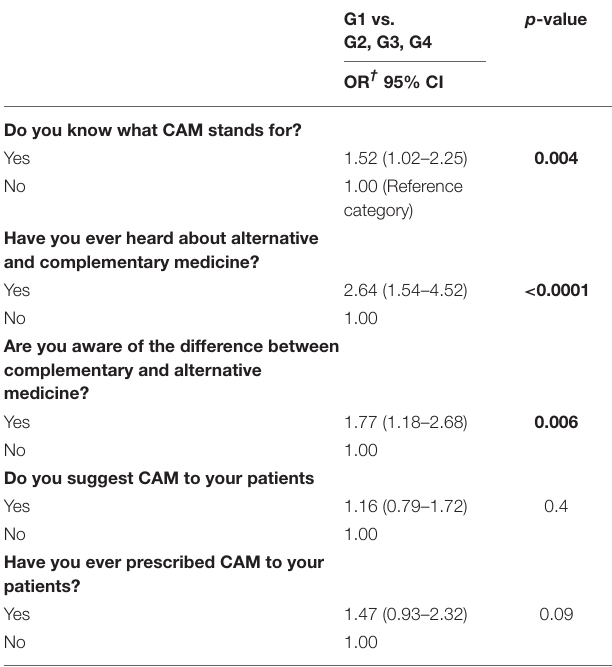
TABLE 6 | Odds ratio (OR) and 95% confidence intervals (CIs) computed to TABLE 5 | CAM knowledge in relation to participants’ involvement in assess the attitudes toward CAM of G1 physicians (specialties: Oncology, research activity. Hematology, Pain management, Radiotherapy, Are you involved in research activity?